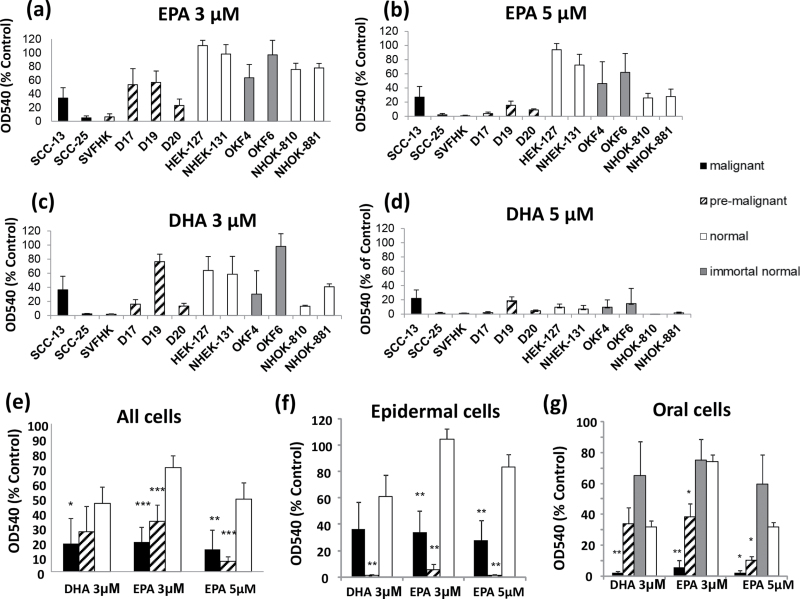
The effect of n-3 PUFAs on the growth of normal, premalignant and malignant
keratinocytes.The growth of the keratinocytes was measured by the MTT viability assay 4 days after
the addition of the n-3 PUFAs at the indicated doses.The effect of 3 µM EPA (a), 5 µM EPA (b), 3
µM DHA (c) and 5 µM DHA (d) on the growth of
the malignant (black), premalignant (hatched), normal (white) and immortal normal
(grey bars) keratinocytes is shown, as determined by the MTT assay. The results are
the means of three or more experiments ± standard error of the mean (SEM).
(e) An overview of the means ± SEM of the MTT assay for the
malignant (black), premalignant (hatched) and normal keratinocytes (white) averages.
The overview for the epidermal keratinocytes (f) and the oral
keratinocytes (g) is shown, where the immortal normal oral lines are
included (grey bars).Significantly different from the mean value of normal keratinocytes
(*P < 0.05; **P < 0.01;
***P < 0.001 as measured by the Mann–Whitney
U-rank test).The malignant cells include SCC-25 (oral) and SCC-13 (epidermal). The premalignant
cells include the three oral dysplasias (D17, D19 and D20) and the epidermal
SVHFK.The normal cells include the normal oral lines (NHOK-810 and NHOK-881), the epidermal
lines (HEK-127 and NHEK-131) and the immortal normal oral lines OKF6/TERT-1 and
OKF4/cdk4R/p53DD/TERT.